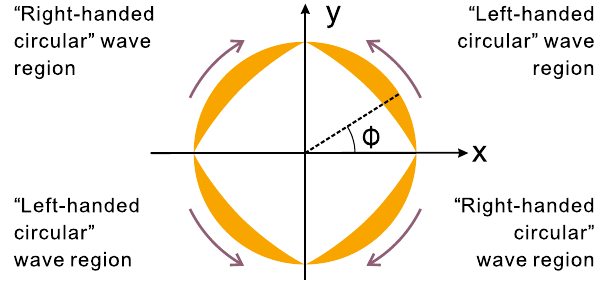
Fig. 7 The strength distribution of transverse background photon flux n ( 0 ) φ , Eq. (46), in the cylindrical polar coordinates